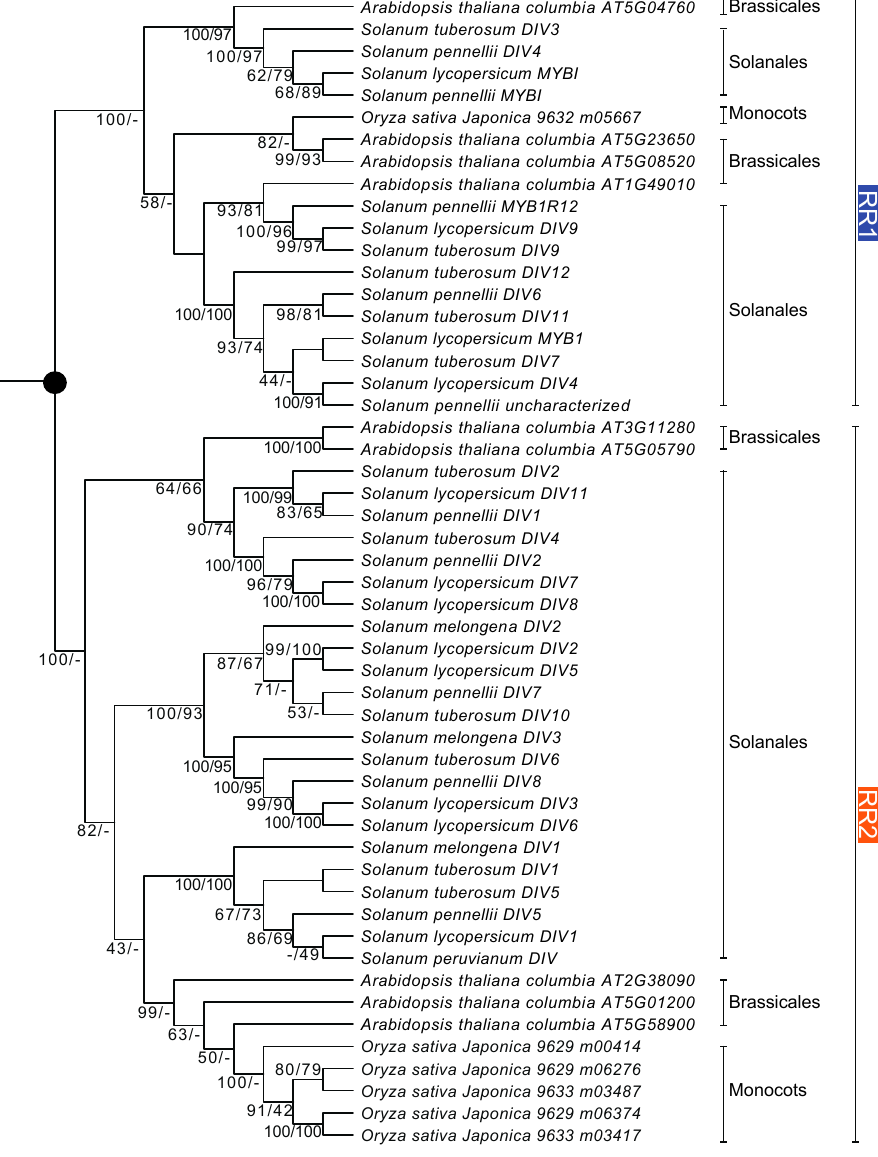
Figure 3. Phylogeny of R-R- type genes of five species of Solanum , Arabidopsis thaliana , and Oryza sativa based on Bayesian and ML inferences. Two major clades, RR1 and RR2, were identified, each of which includes sequences from Arabidopsis , Oryza , and Solanum . Bayesian posterior probabilities and bootstrap frequencies ≥ 40% depicted close to the branches, respectively.